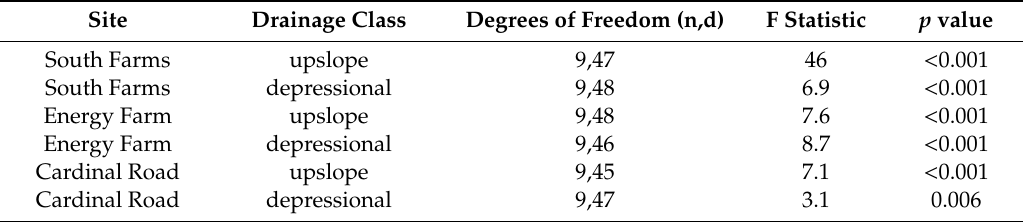
Figure 6. Effect size of treatments on soil N 2 O emissions from upslope ( a – c ) and depressional ( d – f ) soils from the South Farms ( a , d ), the Energy Farm ( b , e ), and Cardinal Road ( c , f ) during the late season experiment. The treatment effect was calculated as the difference between net N 2 O emissions from soil receiving a given treatment amendment compared to unamended control soils. Error bars represent propagated standard error ( n = 5) of the difference between the control and treatment means. Colors represent each treatment. Gray shading indicates when soils were flooded. Table 2. Results from ANOVAs run on mixed e ff ects models examining the treatment e ff ect on soil N 2 O emissions during the late season lab